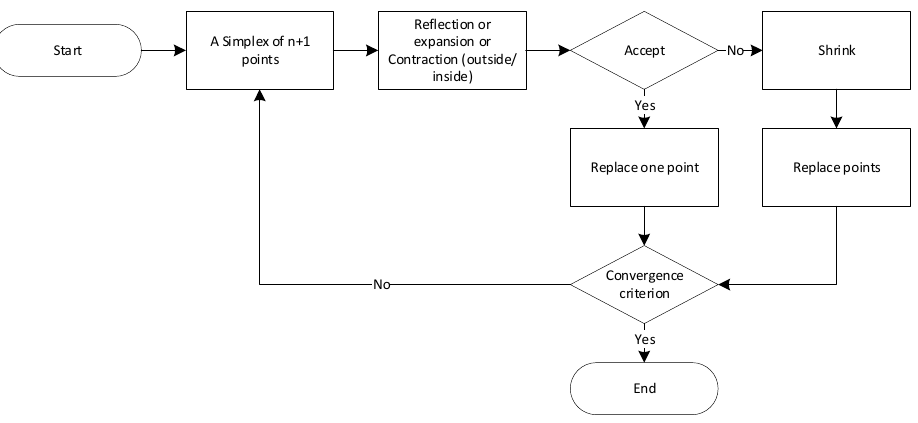
Figure 3. The flowchart of the Nelder–Mead simplex method.